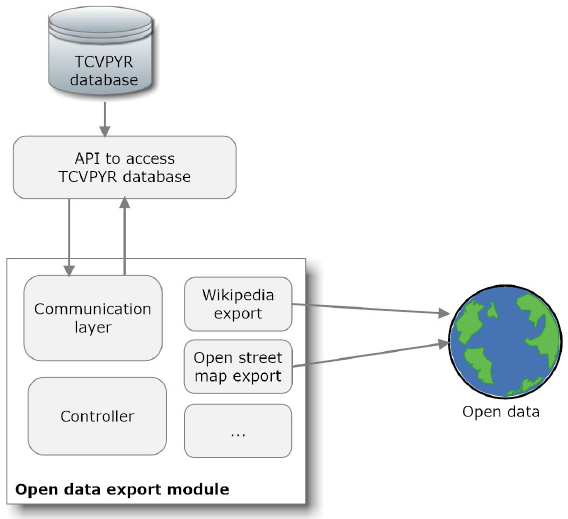
Figure 5. Cultural heritage data dissemination through open data